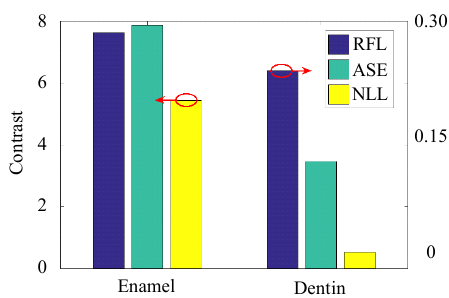
Fig. 8 Contrast ratios of enamel and